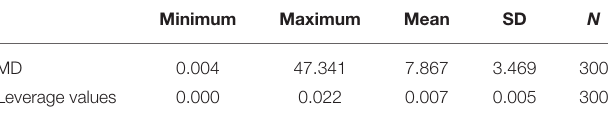
TABLE 3 | Outlier detection with Mahalanobis